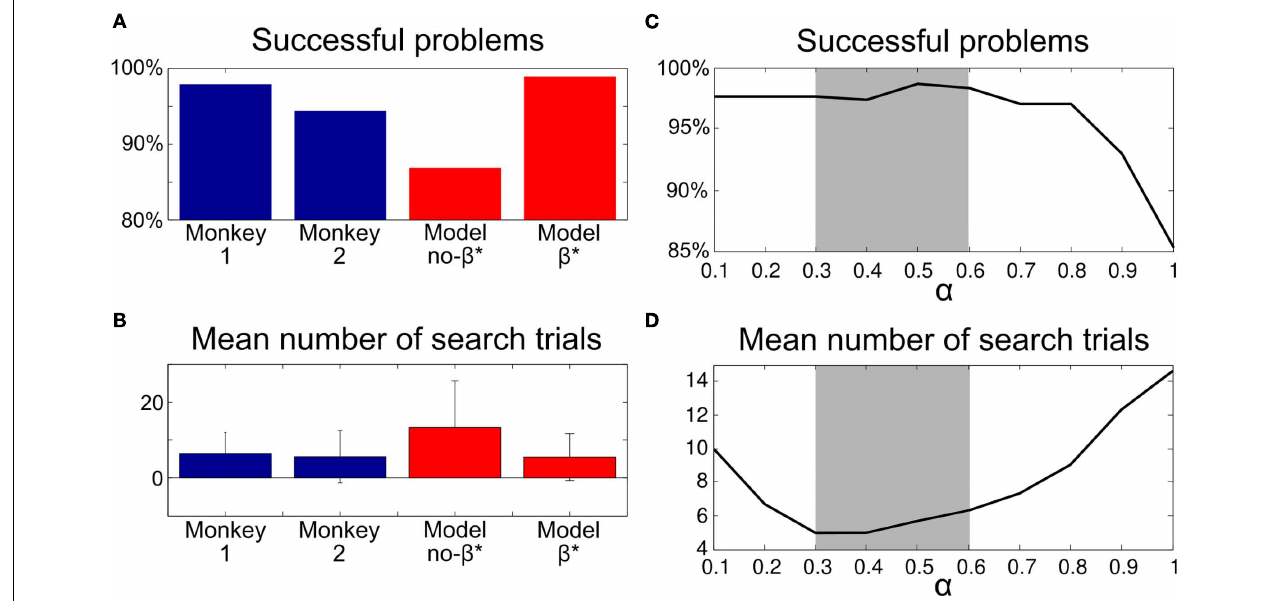
for different values of α tested with the model with β ∗ . (D) Duration of the search phase for the same tests.Without the dynamic regulation of the exploration level computed with β ∗ , the model produced worst performance than monkeys. Errorbars: